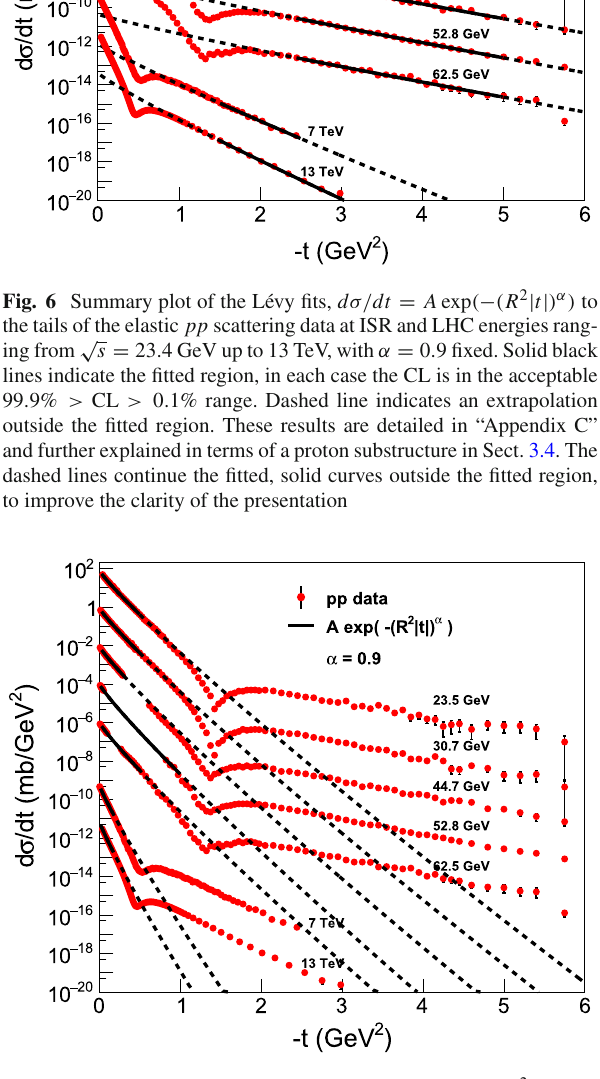
Fig. 7 Summary plot of the Lévy fits, d σ/ dt = A exp ( − ( R 2 | t | ) α ) to the cone (or low- | t | ) region of the elastic pp scattering data at ISR and √ s = 23 . 4 GeV to 13 TeV, with α = 0 . 9 LHC energies ranging from fixed. The dashed lines continue the fitted, solid curves outside the fitted region, to improve the clarity of the presentation. These fits are detailed and described individually in “Appendix